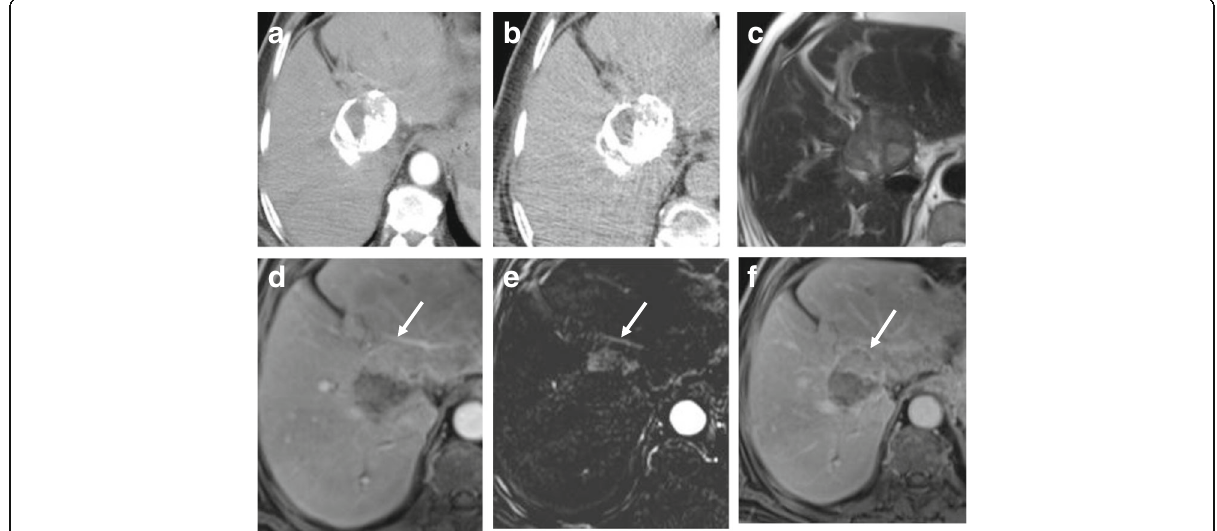
Fig. 1 CT versus MRI after TACE. a Arterial phase CT shows heterogenous lipiodol condensation without appreciable enhancement. b Delayed phase CT shows heterogenous lipiodol condensation without appreciable washout. c T2-WI shows a heterogenous signal. d Enhanced T1-WI in the arterial phase shows non-enhancement in most of the lesion with faintly enhancing peripheral nodule (arrow). e Subtracted image confirms non-enhancement in most of the lesion with a faintly enhancing peripheral nodule (arrow). f Enhanced T1-WI in the delayed phase shows washout of the faintly enhancing peripheral nodule (arrow). Final diagnosis is LR-TR viable which is highlighted by MRI, not by